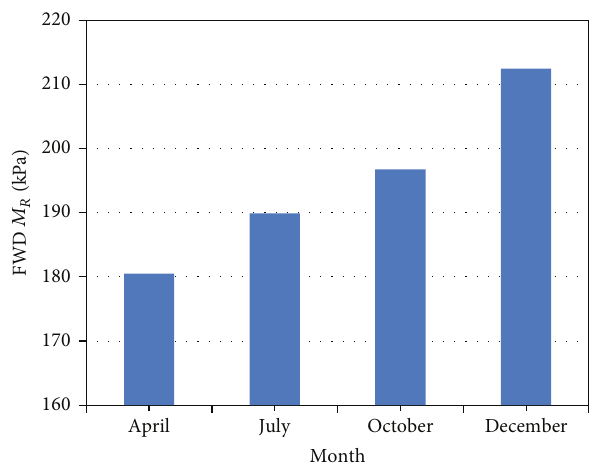
Figure 8: Seasonal variation of FWD 𝑀 𝑅 in test